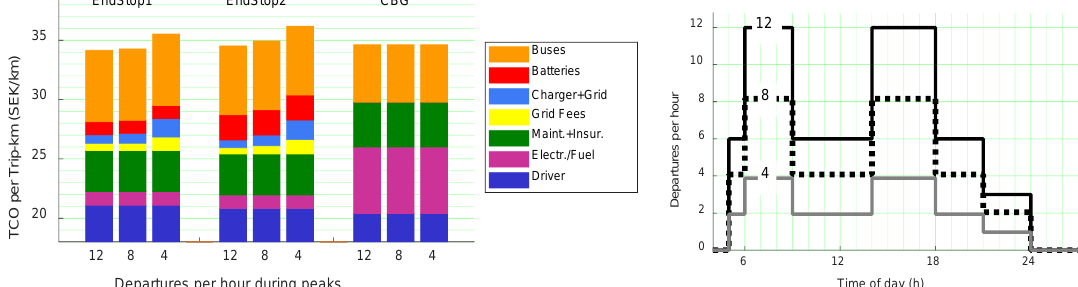
Figure 13. The cost per km for end-stop-charged and biogas (CBG) buses with varying bus traffic density for a whole day. (Note that the y -axis starts at 18 SEK/km, so the driver cost is more than half the TCO).